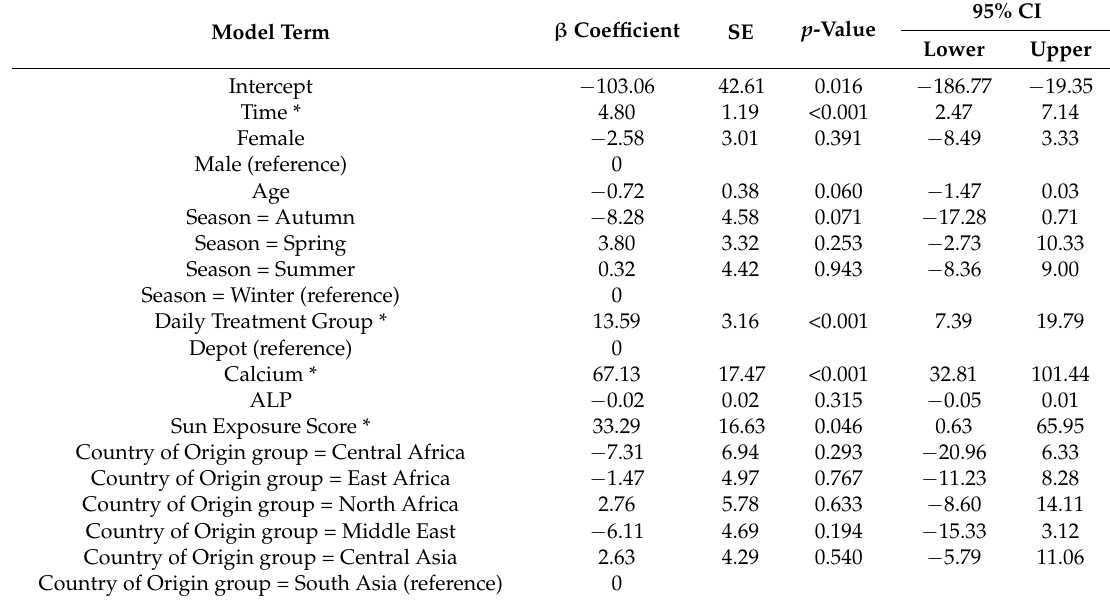
Table 4. Generalized Linear Mixed Models (GLMM) Model 1 Parameter Estimates for Vitamin D serum levels (25(OH)D nmol/L).